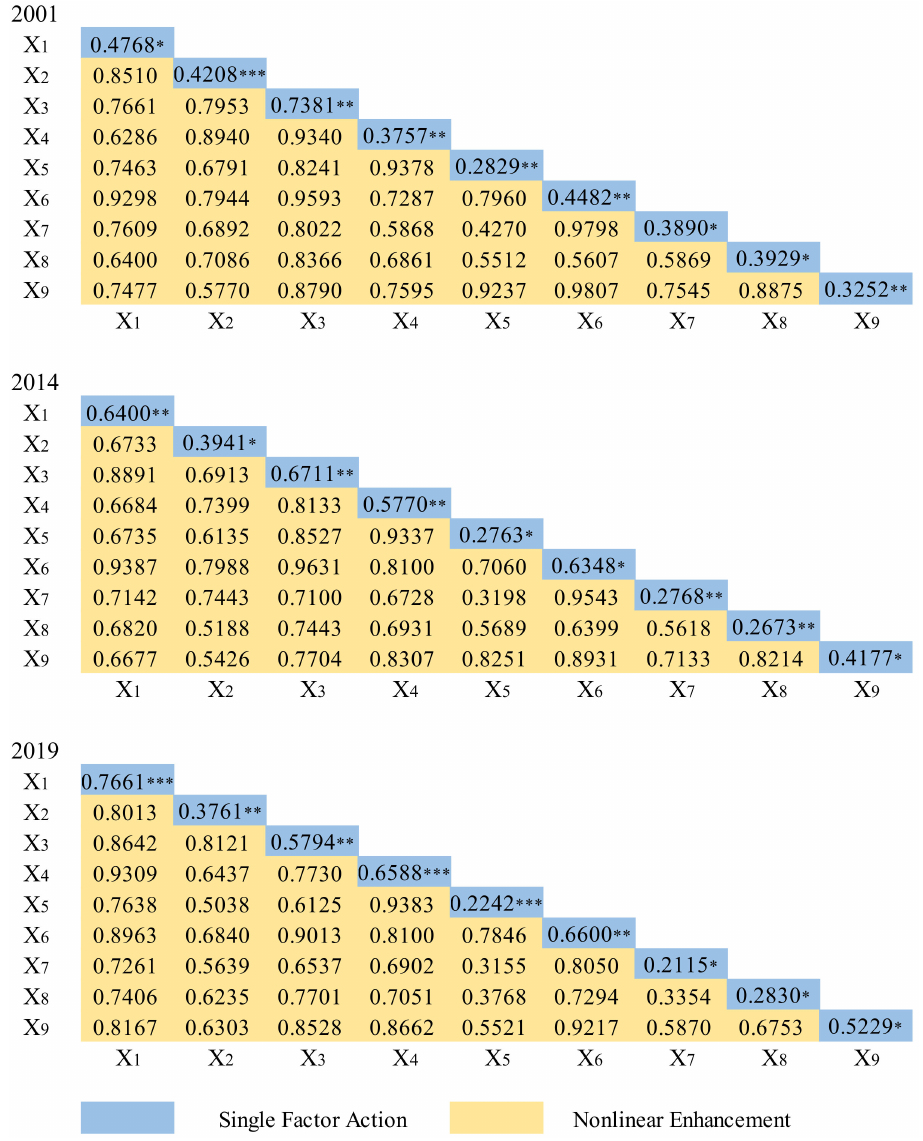
Figure 5. Interactive detection results for factors influencing the development performance of small towns in Jiangyin. * represents significance at the 0.05 level, ** represents significance at the 0.01 level, *** represents significance at the 0.001